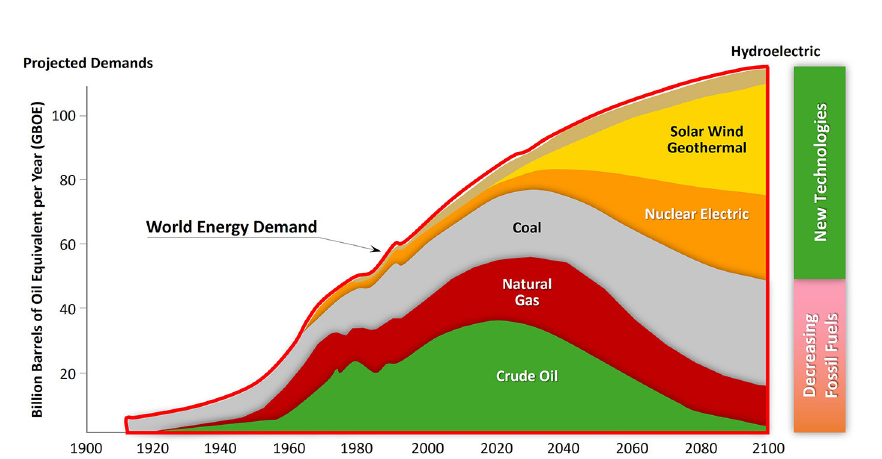
Fig. 27. – One possible forecast of sources of energy required to reduce greenhouse gas emissions, reduce energy poverty and satisfy growing world energy demand to